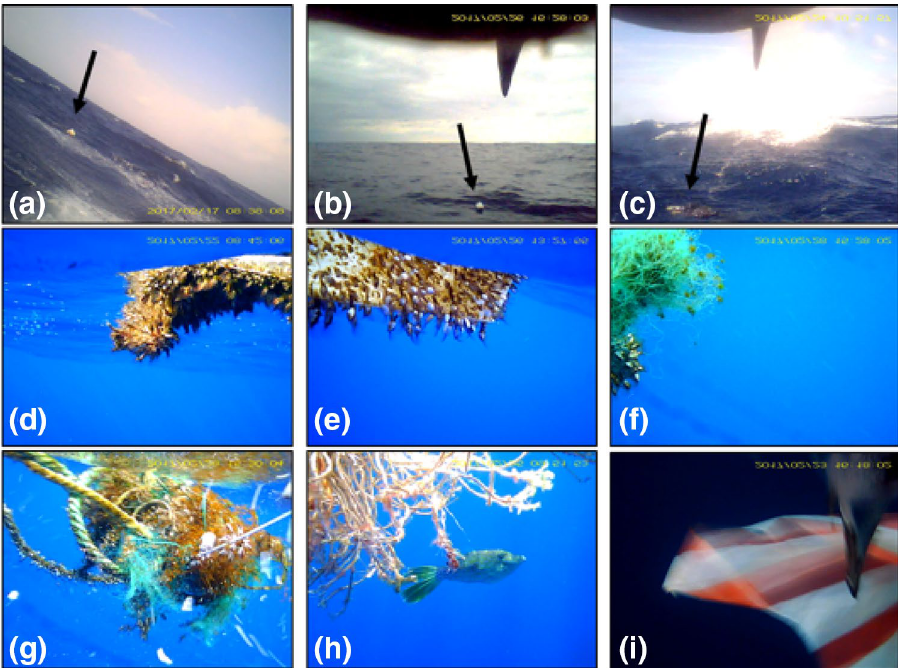
Figure 2. Examples of marine debris floating at the sea surface, recorded by video-loggers fitted on black- footed albatrosses breeding on Torishima, Japan. Styrofoam recorded from Bird 31 ( a ), styrofoam, Bird 48 ( b ), plastic, Bird 39 ( c ), plastic with barnacles, Bird 42 ( d ), styrofoam with barnacles, Bird 46 ( e ), fishing net with barnacles, Bird 49 ( f ), fishing net and rope with barnacles, Bird 49 ( g ), rope used in fisheries, harboring a Aluterus scriptus filefish, Bird 43 ( h ), and Bird 44 pecking at a plastic sheet ( i ). Images were extracted from footage taken during flight bouts ( a – c ), or during sitting-on-water bouts ( d – i